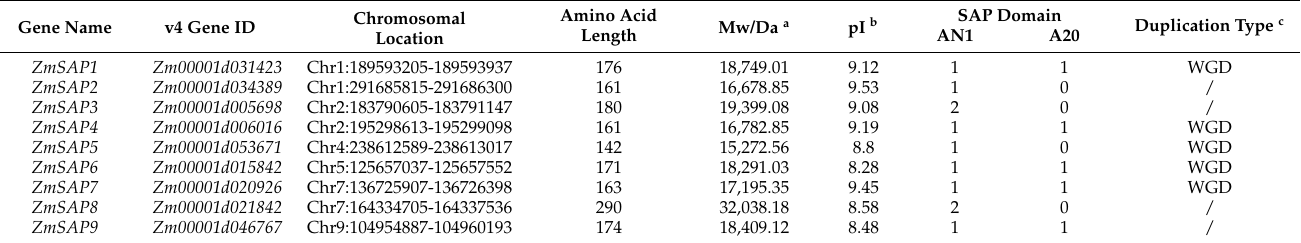
Table 1. Information of SAP genes in maize.